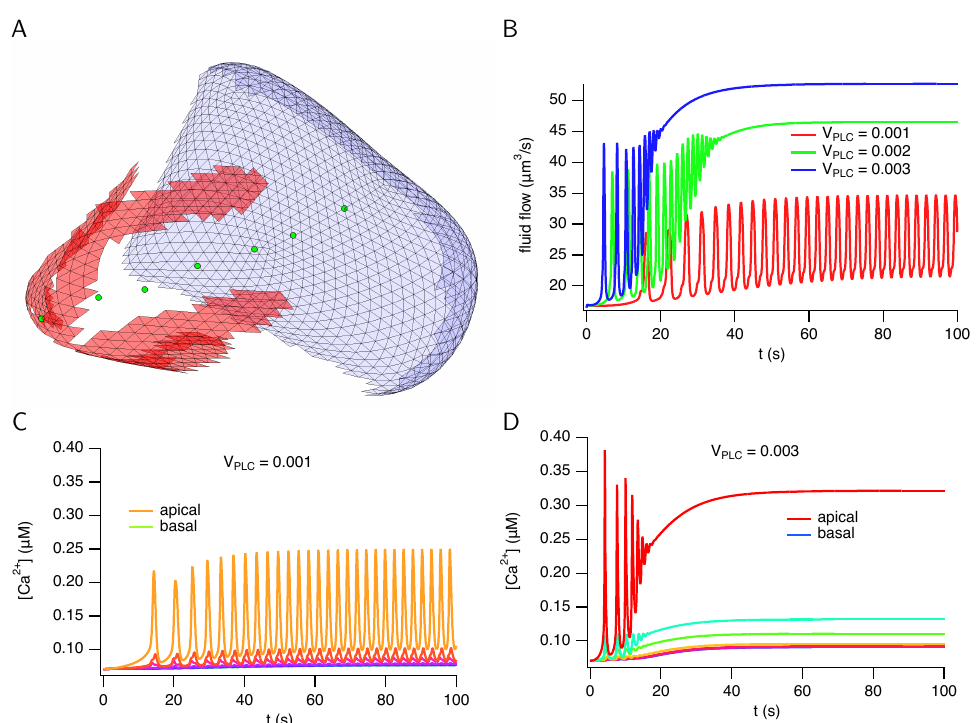
Figure 9. Calcium responses and fluid flow in a simulated cell. ( A ): the cell membrane, showing the triangles used in the finite element mesh. Red triangles are apical membrane and blue triangles are basal membrane. The lateral membrane (which abuts neighbouring cells) is omitted for clarity. The green circles show the places for which the Ca 2 + responses are plotted in panels ( C , D ). ( B ): total fluid flow plotted over time for three different stimulation levels. ( C , D ): Ca 2 + responses from seven different positions in the cell, denoted by the green circles in ( panel A